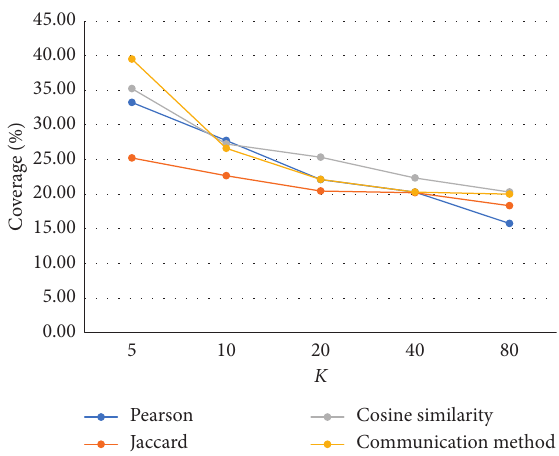
Figure 5: Coverage of different user similarity calculation methods under multiple K values.